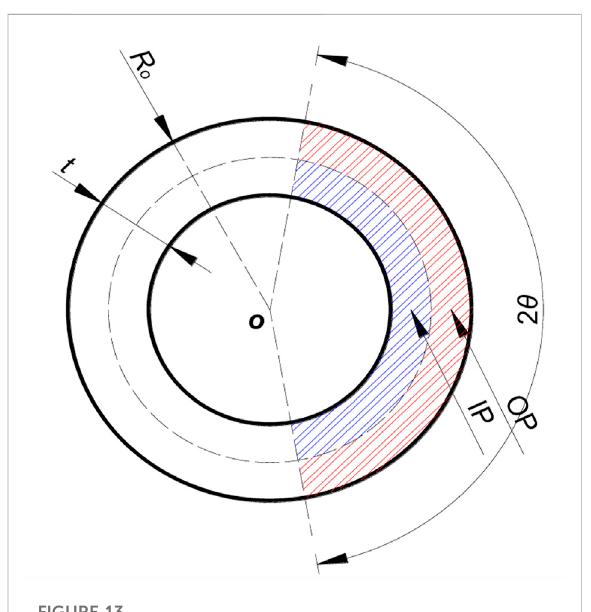
FIGURE 13 Inner ring region IP and outer ring region OP.